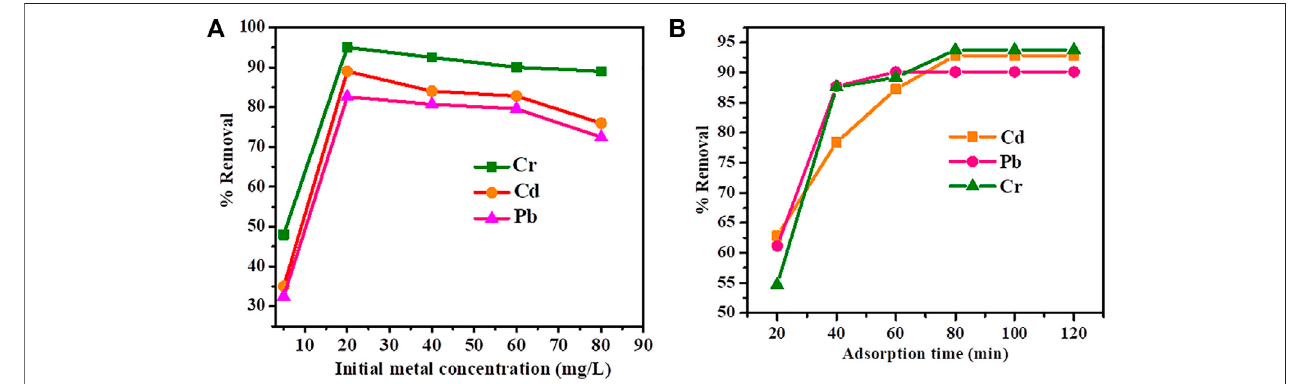
FIGURE 4 | Effect of (A) initial metals ion concentration and (B) contact time on removal ef fi ciency of Pb, Cd and Cr.